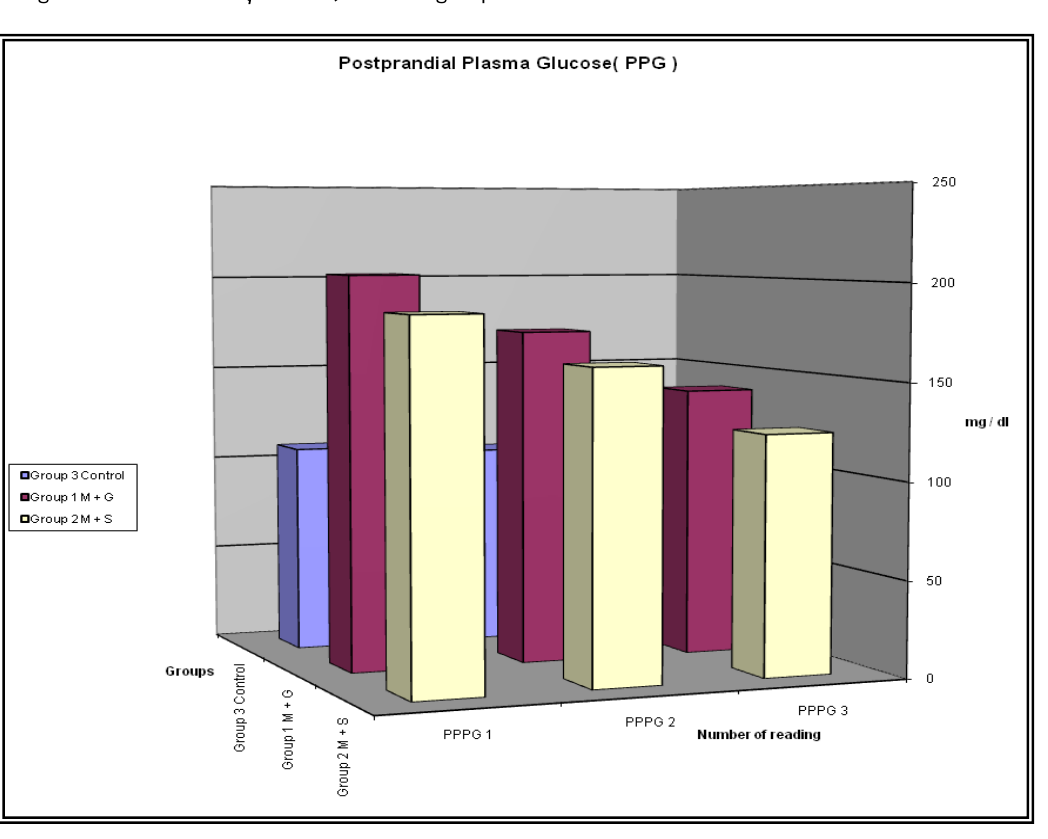
Values expressed as mean ± standard error of mean.